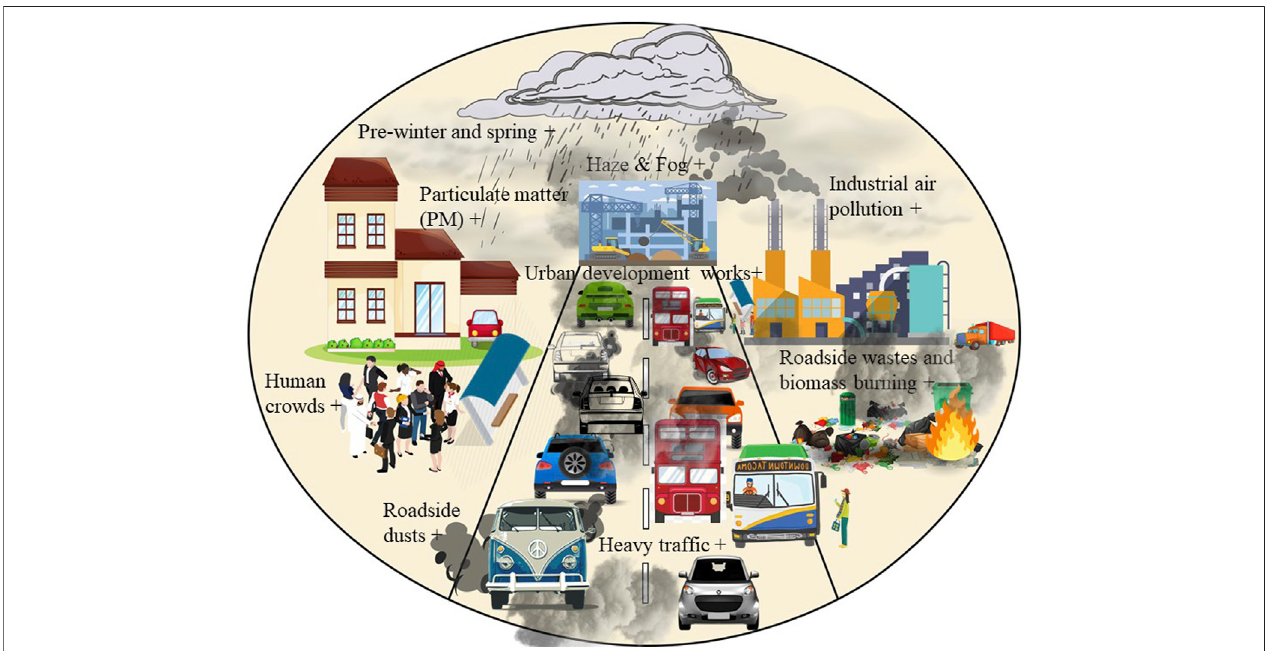
FIGURE 2 | Factors in fl uencing bioaerosols load (indicated by +) in association with the development of particulate matter ( > 2.5 – 10 µm) in the outdoor urban/ industrial environments of developing countries. This is suspected to be similar for all tropical South Asian and Southeast Asian cities.